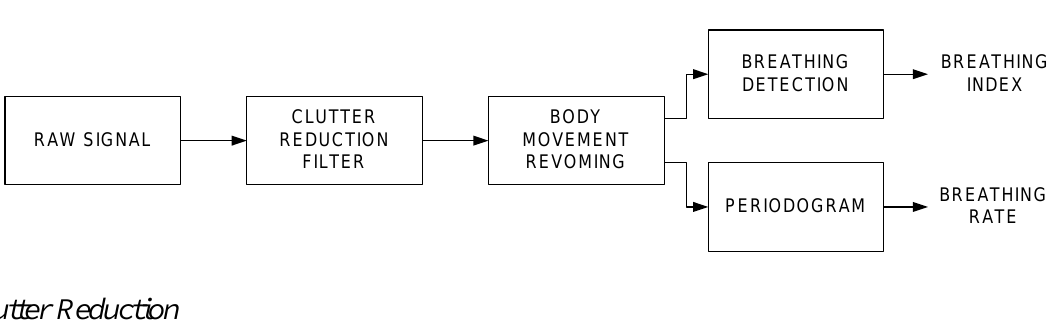
Figure 3. Signal processing block